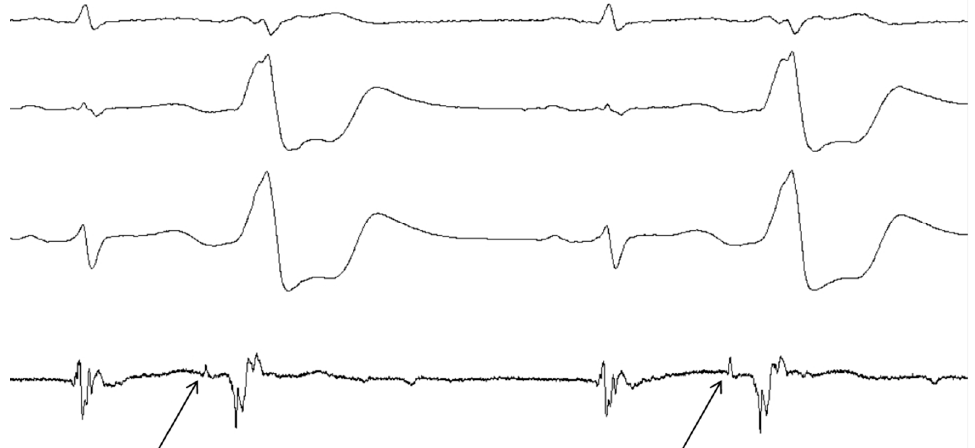
Figure 2. Pre-potentials on Intracardiac ECG. Intracardiac ECG of a patient from our center during catheter ablation of a VA originating from the AMC. Shown are a sinus complex followed by a PVC, which is then repeated. The arrows indicate the pre-potentials representing conduction over some kind of tract with an isoelectric interval of 92 ms.